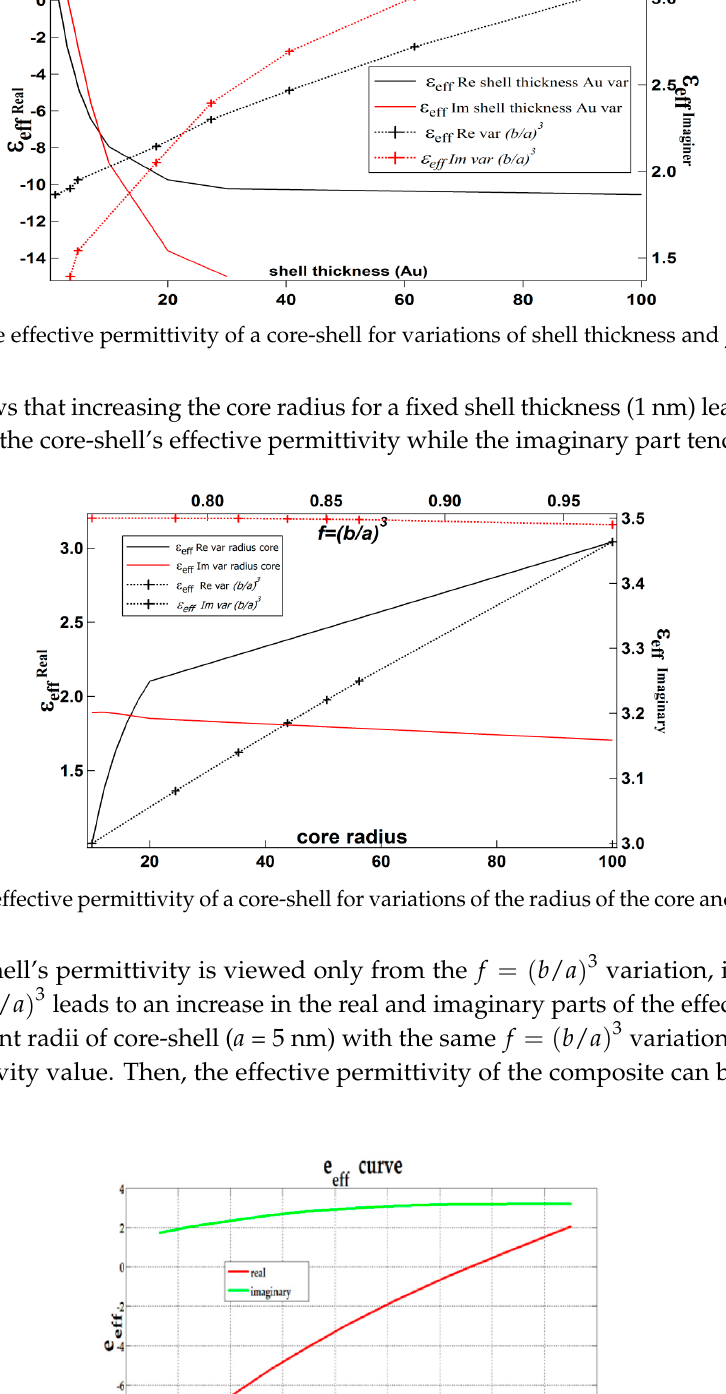
Figure 6. The effective permittivity of a core-shell for variations of f = ( b / a ) 3 .